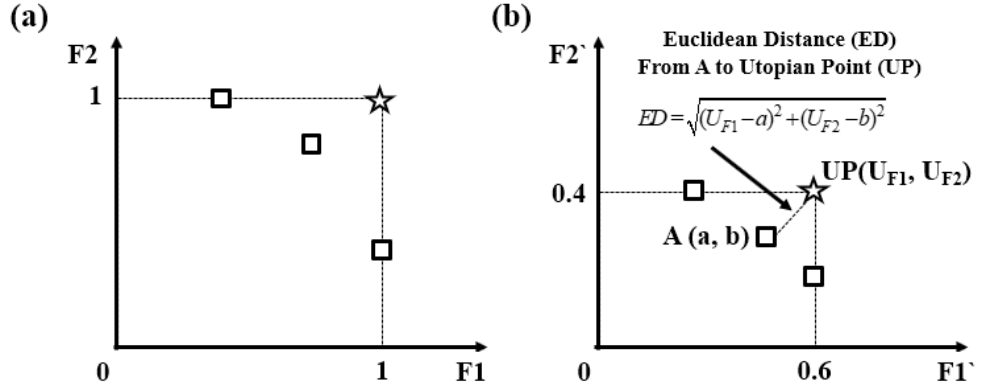
Figure 5. Concept of ( a ) utopian approach; ( b ) weighted utopian approach.